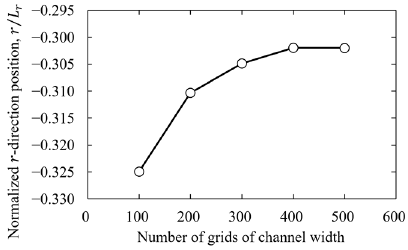
Figure 7. Relationships between the equilibrium position of the particle and the resolution at inner wall side for Re = 64 and C =